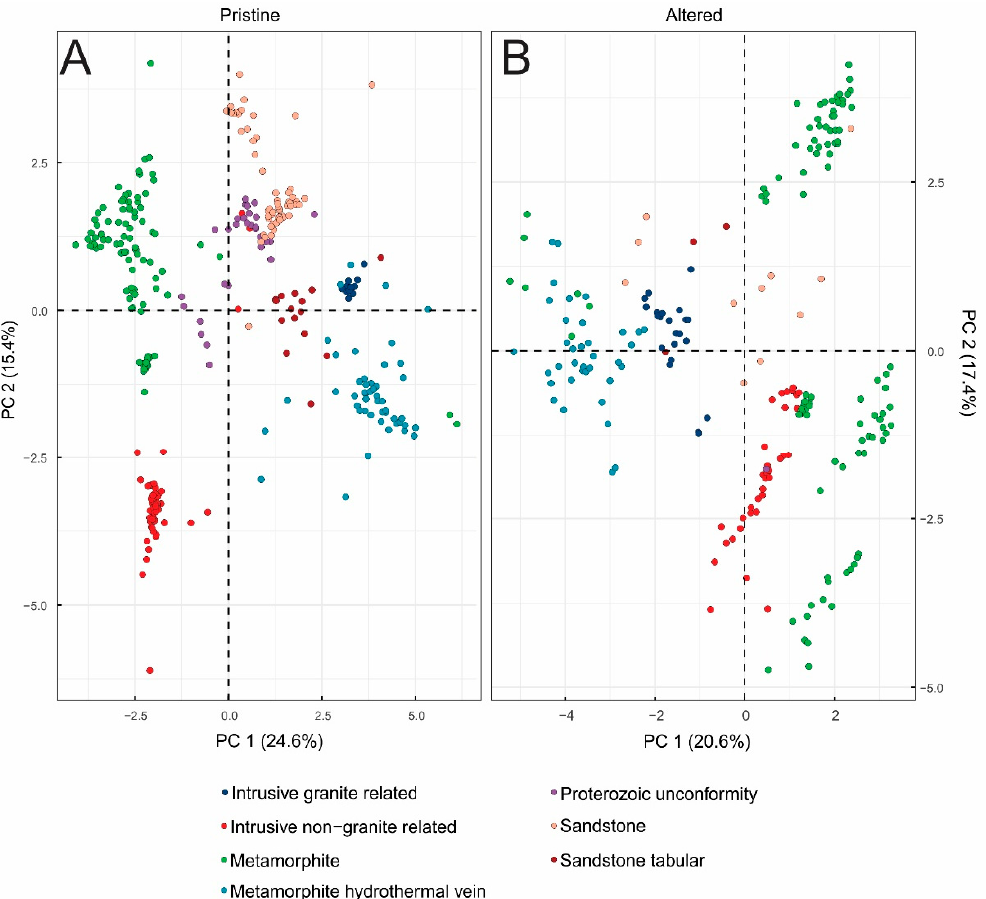
Figure 11. Principal component analysis for ( A ) pristine and ( B ) altered uraninite samples using major elements (wt. %; Table S1) and the Sr, Pb, and U isotopic compositions (Table S4). Two principal